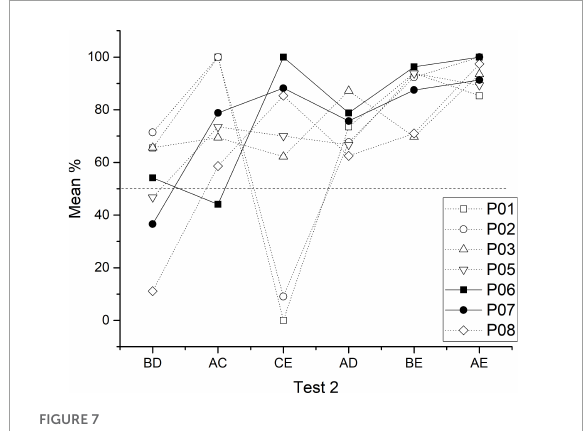
FIGURE7 Individual performance for each test session of test 2. Closed symbols correspond to C + learners and open symbols to non C +